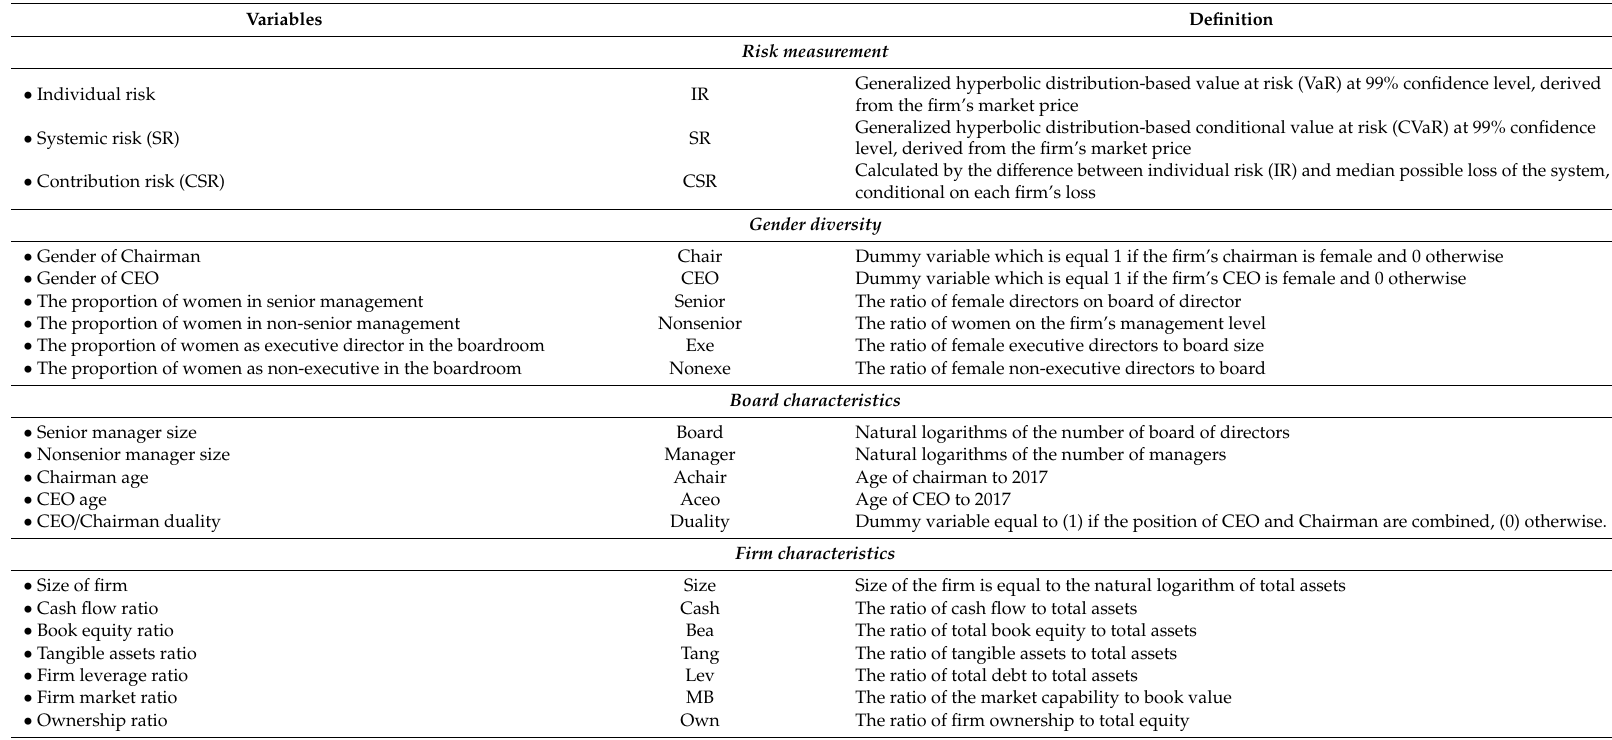
Table 1. Variables